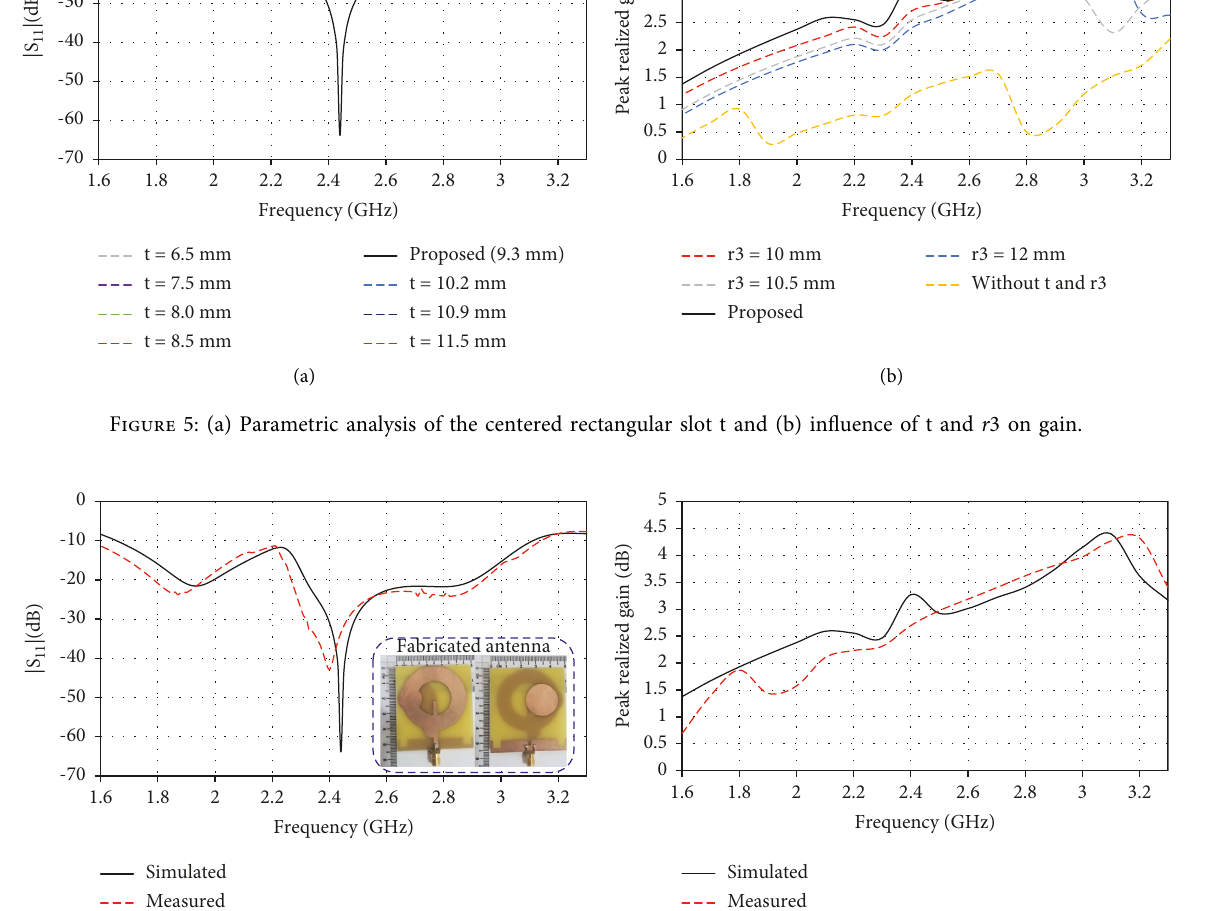
11 |) and (b) peak realized gain of the proposed wideband circular-slot